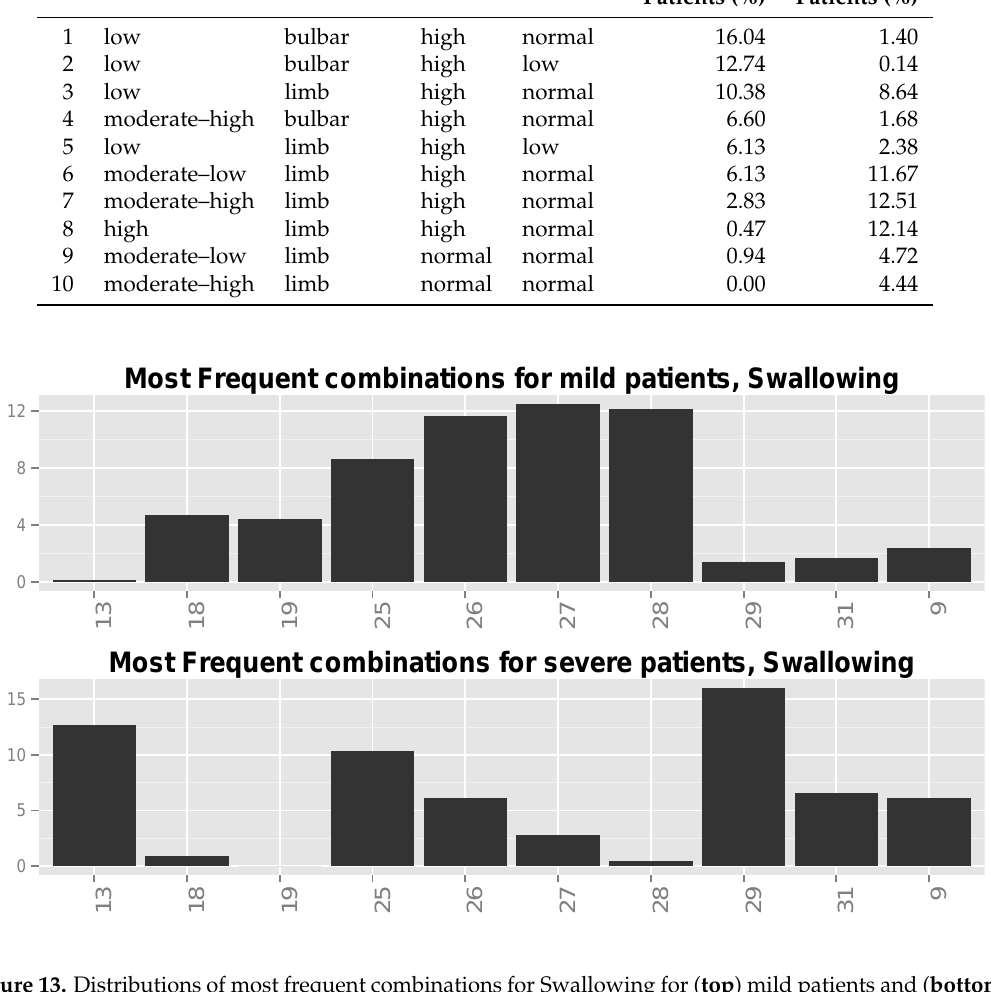
Figure 13. Distributions of most frequent combinations for Swallowing for ( top ) mild patients and ( bottom ) severe patients. Numbers along the x -axis are indices of the